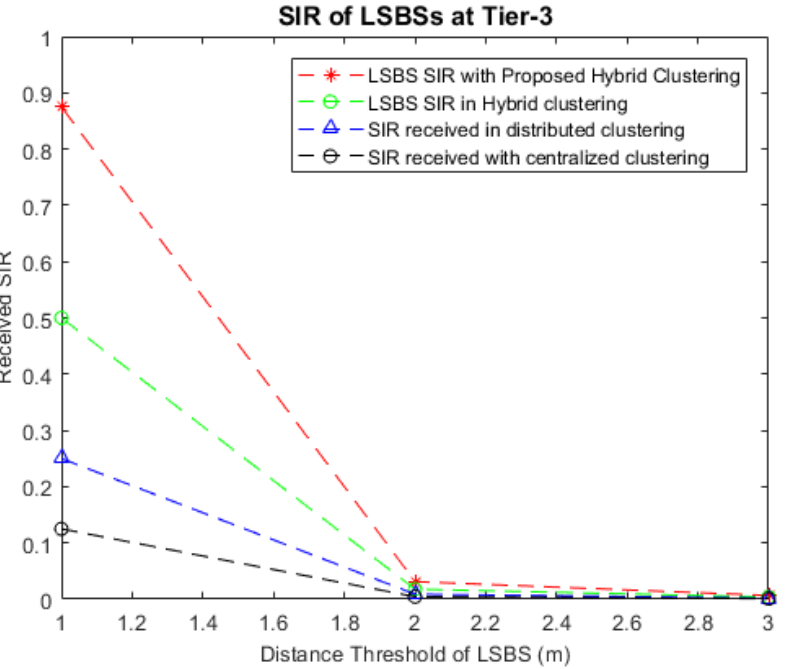
Figure 8. Comparison of received SIR vs. distance in meters at LSBSs with centralized clustering, distributed clustering, existing hybrid clustering, and the IMHC hybrid clustering scheme.